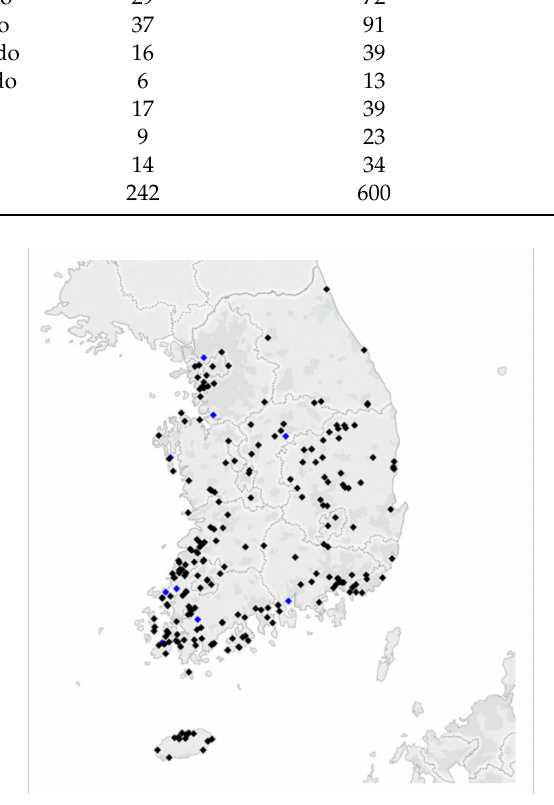
Figure 1. Provincial distribution of the sample PV power plants (the blue symbols correspond to the 10 validation